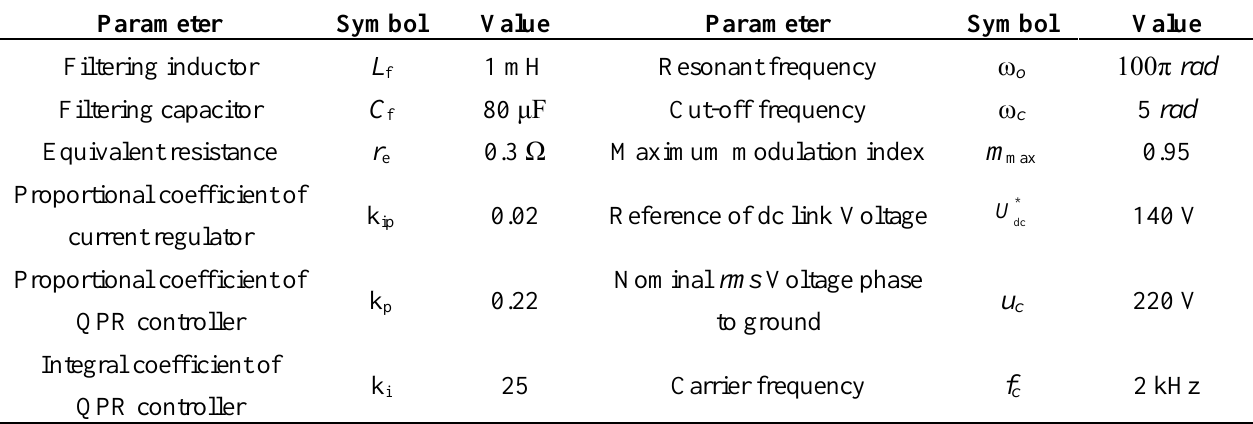
Table 1. Controller and filter parameters of the simulated 10 kW 220 V